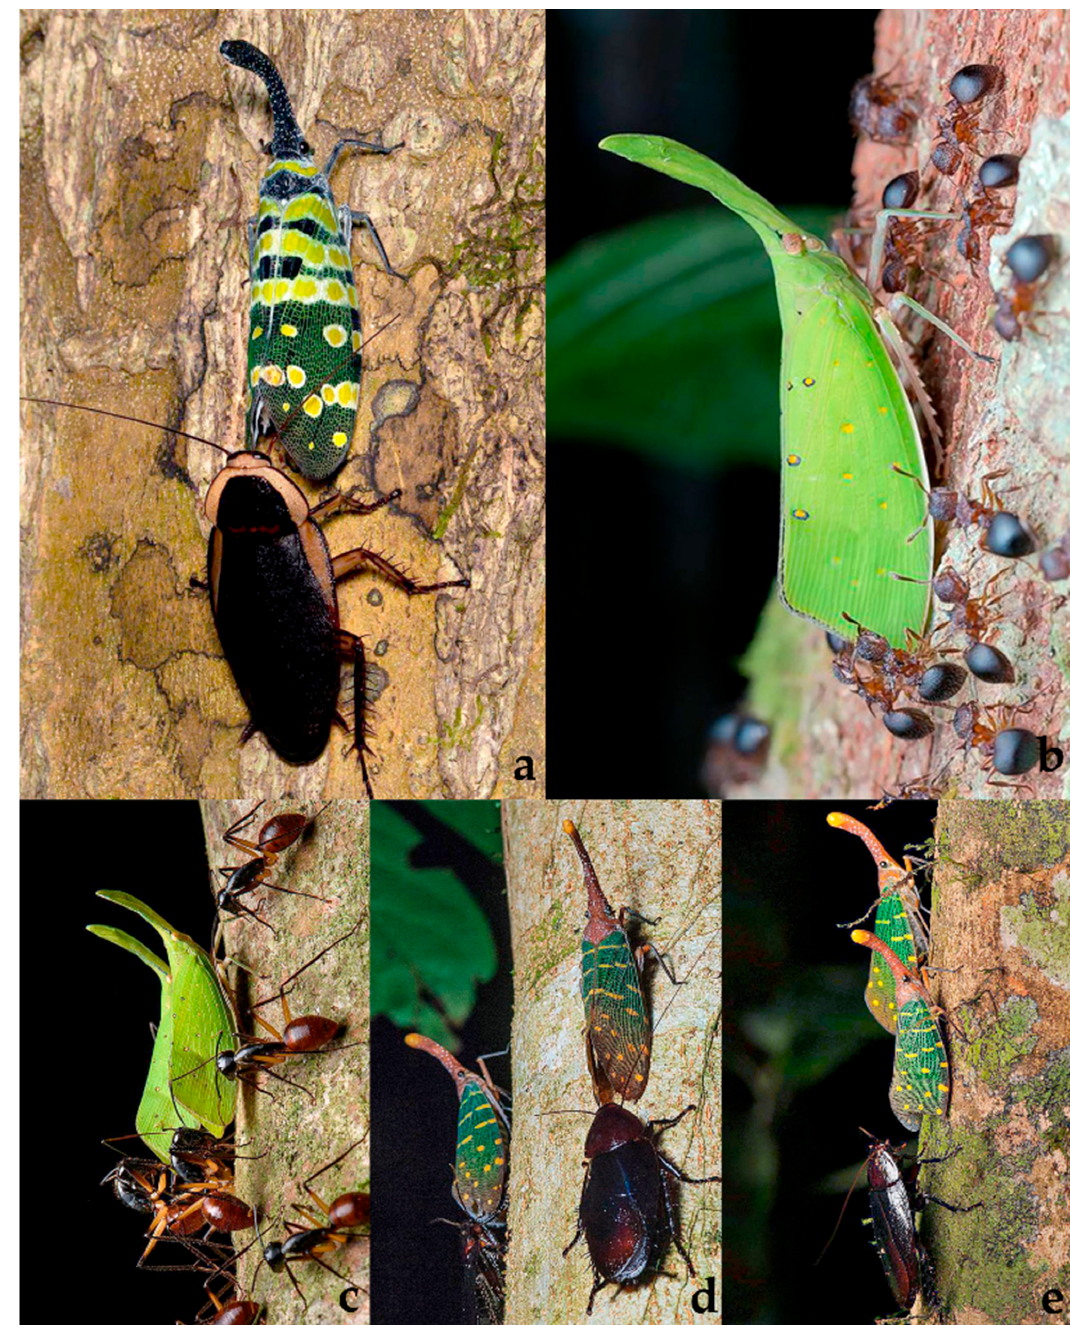
Figure 17. Fulgoridae: ( a ) Pyrops connectens (Atkinson, 1885) tended by Blattodea indet., Thailand: Khao Sok National Park, 8°56 ′ 12 ″ N 98°31 ′ 49 ″ E, 23.07.2018, adult on tree trunk, obs. C. Hübner; ( b ) Pyrops cultellatus yoshiakii Nagai and Porion, 2002 tended by Formicidae indet., Malaysia, 22.12.2015, adult on tree trunk, obs. H.P. Guek; ( c ) P. cultellatus yoshiakii tended by Formicidae: Formicinae: Dinomyrmex gigas (Latreille, 1802), Malaysia: Gunung Ganing National Park, 1°41 ′ 40.1 ″ N 109°50 ′ 40.2 ″ E, 27.08.2018, adult on tree trunk, obs. C. Lee; ( d ) P. intricatus (Walker, 1857) tended by Blattodea indet., Malaysia: Gunung Mulu National Park, 4°02 ′ 29.8 ″ N 114°48 ′ 56.8 ″ E, 01.07.2006, adult on tree trunk, obs. C. Lee; ( e ) P. intricatus tended by Blattodea indet., Malaysia: Gunung Mulu National Park, 4°02 ′ 23.6 ″ N 114°48 ′ 58.1 ″ E, 15.10.2009, adult on tree trunk, obs. C. Lee.